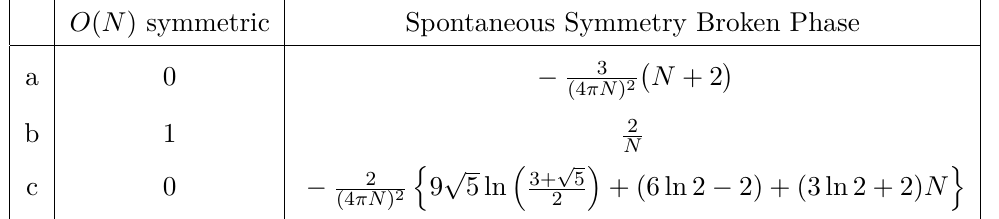
Table 1 . The values of the coefficients a, b, c in the entanglement entropy (1.1) for different